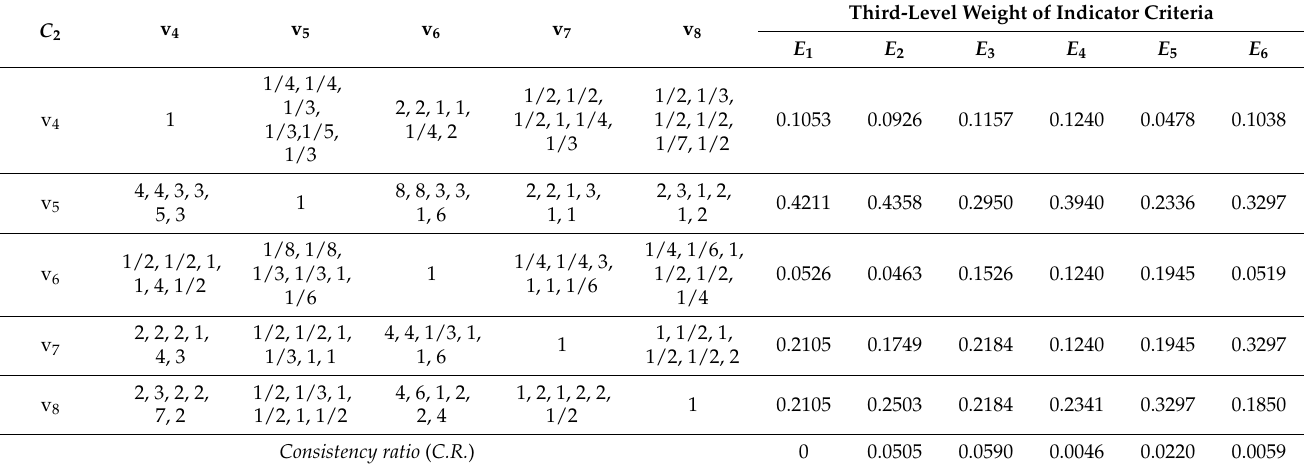
Table 11. Judgment of six experts’ scoring for the importance of technical value indicators.